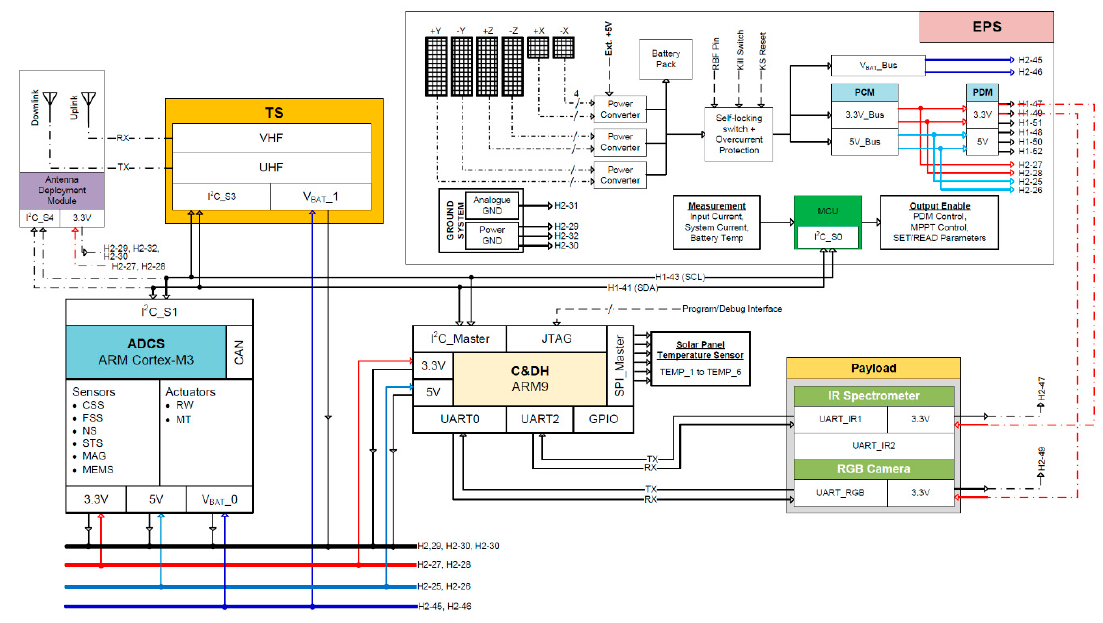
Figure 5. MeznSat system architecture.